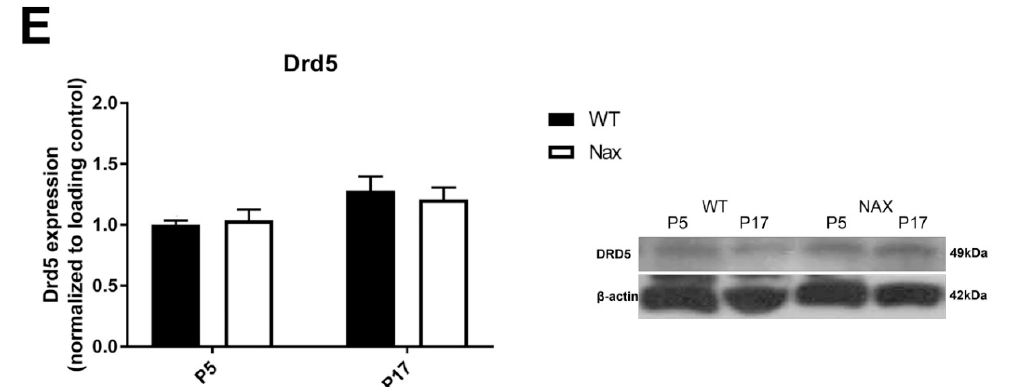
Figure 6. Sagittal sections of wt and nax mouse cerebella: DRD5 expression at P5 and P17. ( A , B ) Immunoperoxidase staining for DRD5 in wt ( A ) and nax ( B ) cerebella at P5 shows weak immunoreactivity in the Pcl. ( C , D ) Immunoperoxidase staining for DRD5 at P17 shows weak immunoreactivity in PCs in the wt ( C ) and nax ( D ) cerebellar cortex. ( E ) Western blot analysis of whole cerebellar lysates revealed no significant differences in DRD5 protein expression between wt and nax cerebella at P5 and P17 (wt: n = 3 and nax : n = 3). The data in the bar graphs are presented as the means of three independent experiments ± SEM, and statistical analysis was performed using two–way ANOVA. P; postnatal. Scale bars: 50 μ m in A and B and 100 μ m in C and D.